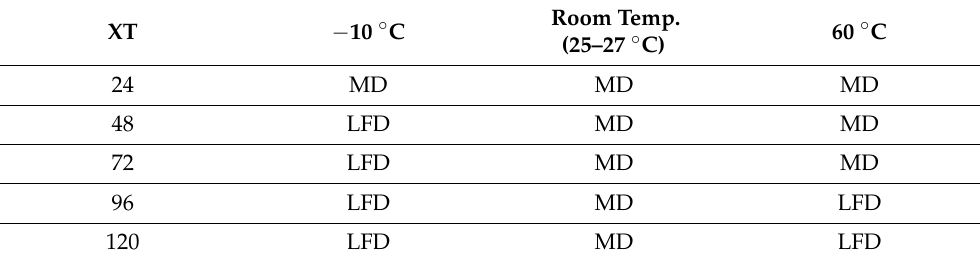
Table 4. The effect of storage time and temperature for latent fingerprints